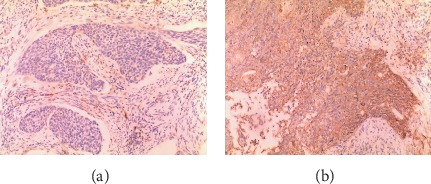
Expression of PD-L1 in cervical cancer cell. Notes: (a) negative and (b) positive expression of PD-L1 in cervical cancer cells (×100 amplification).